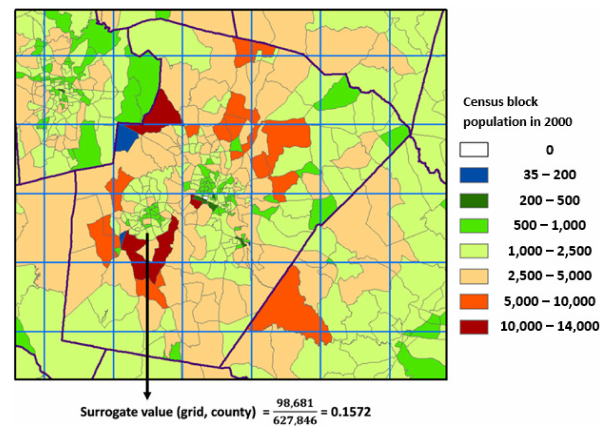
Figure 2. Population-based spatial surrogate computation for CMAQ 12 km modeling grid (blue cells) over Wake County (dark purple polygon), North Carolina area, from the 2000 census popu- lation at the census block group level (grey color